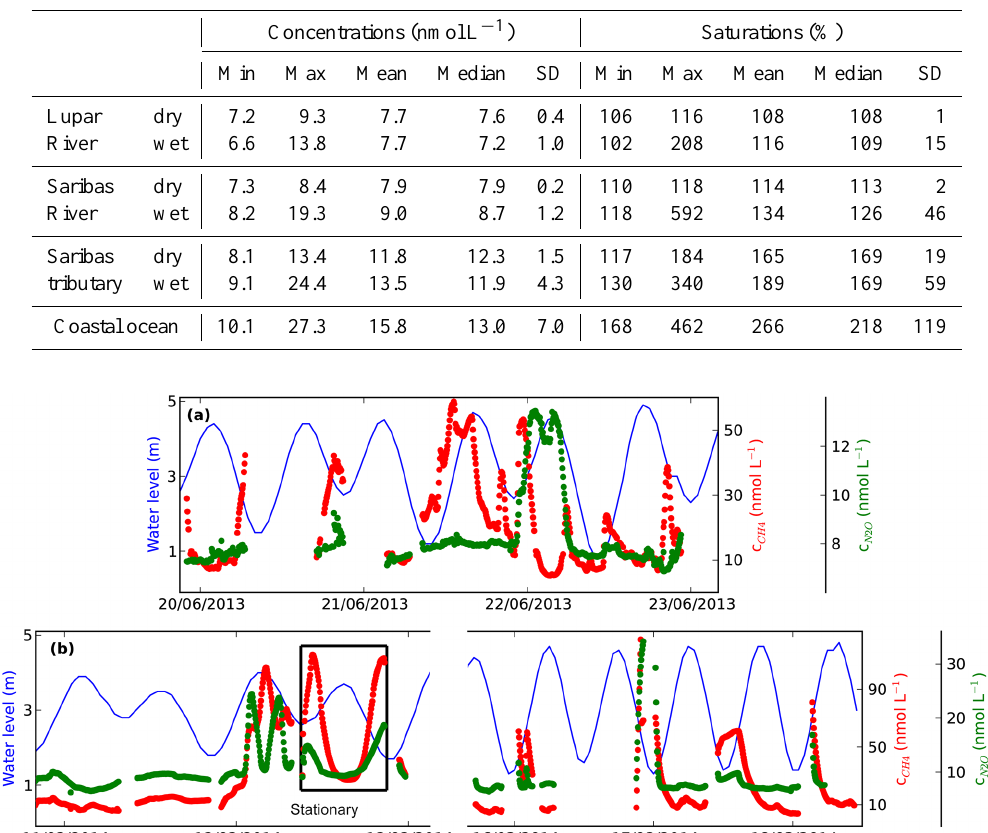
Figure 4. Time series of methane and nitrous oxide concentrations in the Lupar and Saribas estuaries measured during the dry-season (2013) campaign (upper panel) and the wet-season campaign (lower panel) and the water level as predicted for Pulau Lakei ( + 1h for Lupar and Saribas rivers). Spatial, temporal and tidal variations are overlapping in the figure. One stationary measurement, as recorded on the Saribas River in 2014, is denoted with the black box. Note the discontinuous time axis in the lower